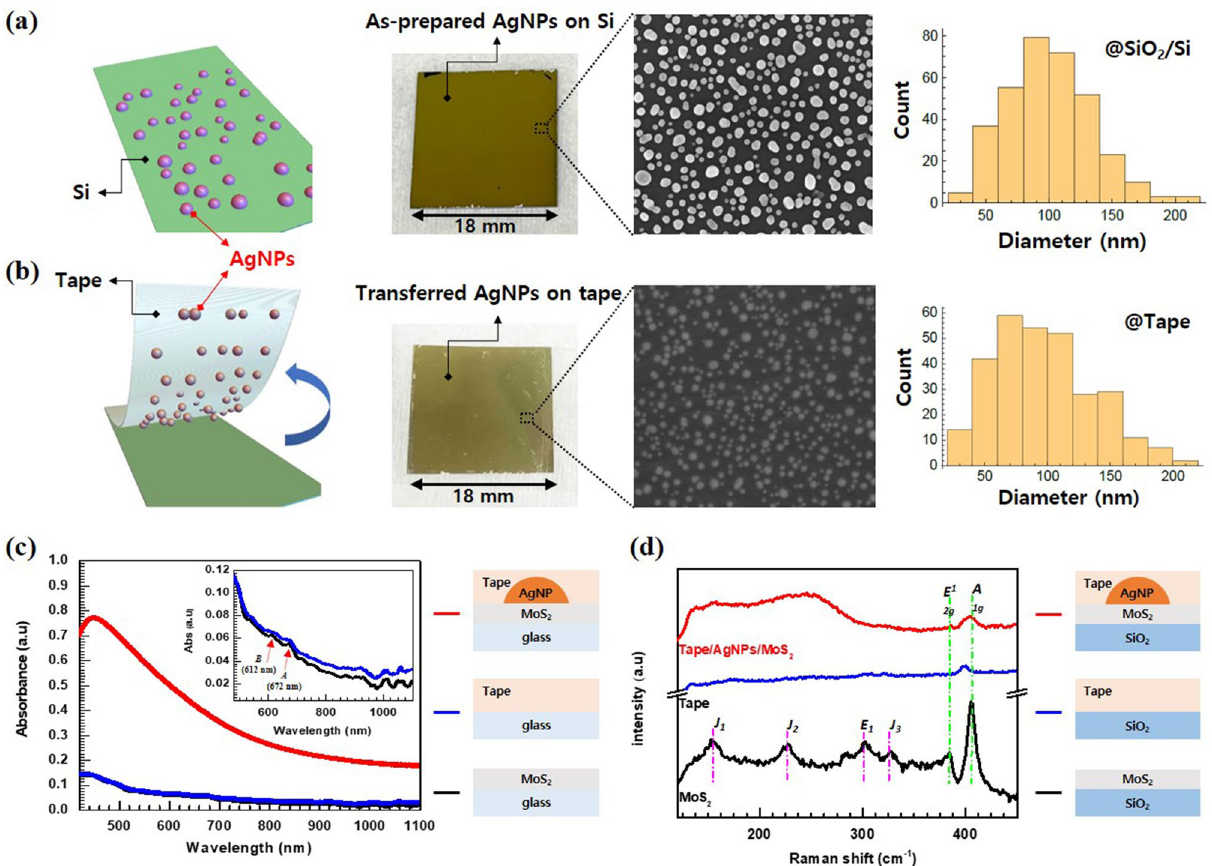
Figure 2. Photographs, SEM images, and size distribution histograms of ( a ) as-prepared AgNPs on Si substrate and ( b ) AgNPs transferred onto 3 M tape. ( c ) UV–Vis–NIR absorbance spectra of multilayered MoS 2 on a glass substrate with and without plasmonic AgNPs. ( d ) Raman spectra of plasmonic tape/MoS 2 , bare tape, and bare MoS 2 film on the glass